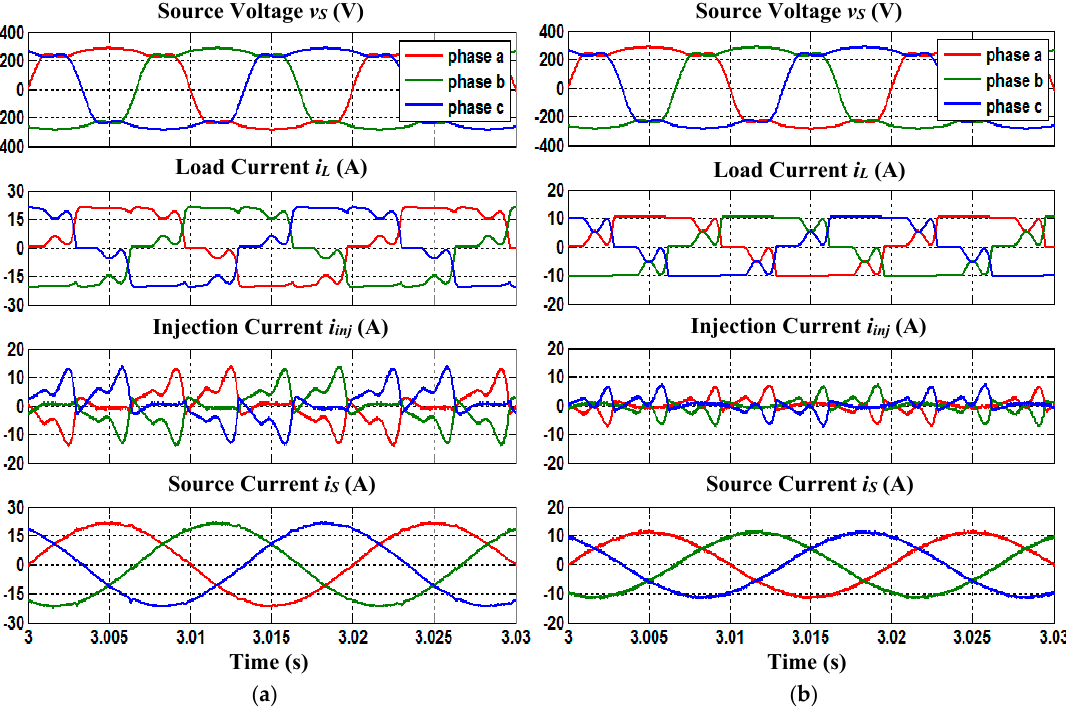
Figure 3. Steady-state simulation waveforms (case 1) of SAPF utilizing the refined STF-pq theory algorithm which include three-phase source voltage v S , load current i L , injection current i inj and source current i S for ( a ) resistive and ( b ) inductive loads.